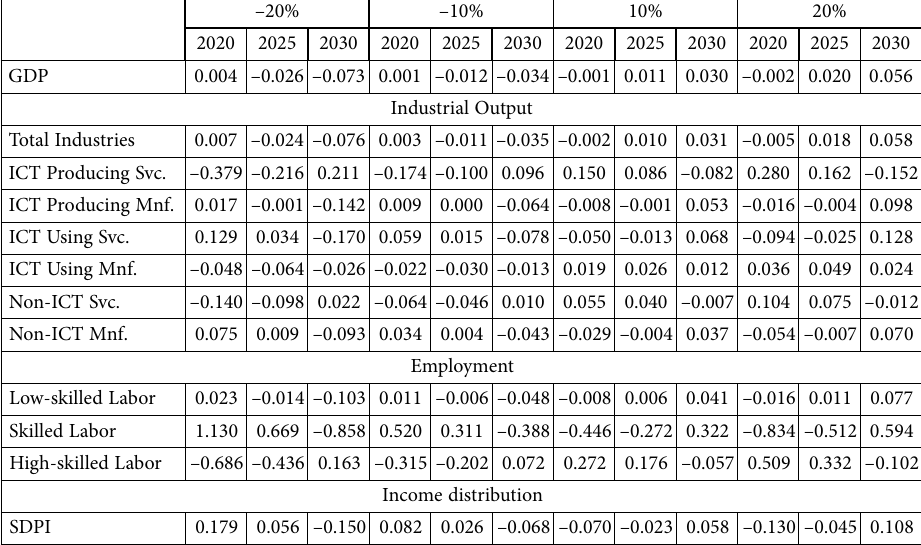
Table B2. Major variables under alternative elasticity of substitution between ICT capital composite and physical capital ( s 2